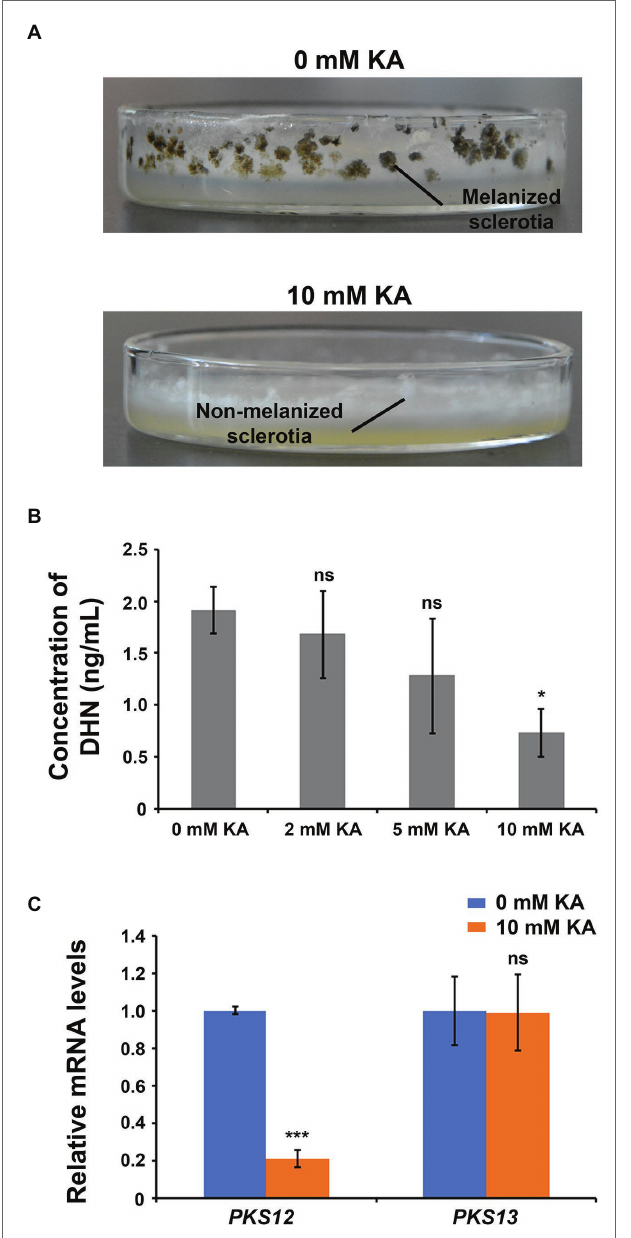
FIGURE 2 | Kojic acid inhibits melanin biosynthesis and sclerotia formation in Sclerotinia sclerotiorum . (A) Images showing sclerotia formation after treatment with 10 mM KA (1.42 mg/ml KA). (B) Concentration of 1,8-dihydroxynaphthalene (DHN) in S. sclerotiorum cells after treatment with 10 mM KA (each treatment mean represents the average of three repetitions). (C) Relative mRNA levels of key genes involved in the biosynthesis of DHN and other melanin compounds after treatment with 10 mM KA (each treatment mean represents the average of five repetitions). Significance levels at * p < 0.05, *** p < 0.001, and no significance (ns). Bars represent the SD.